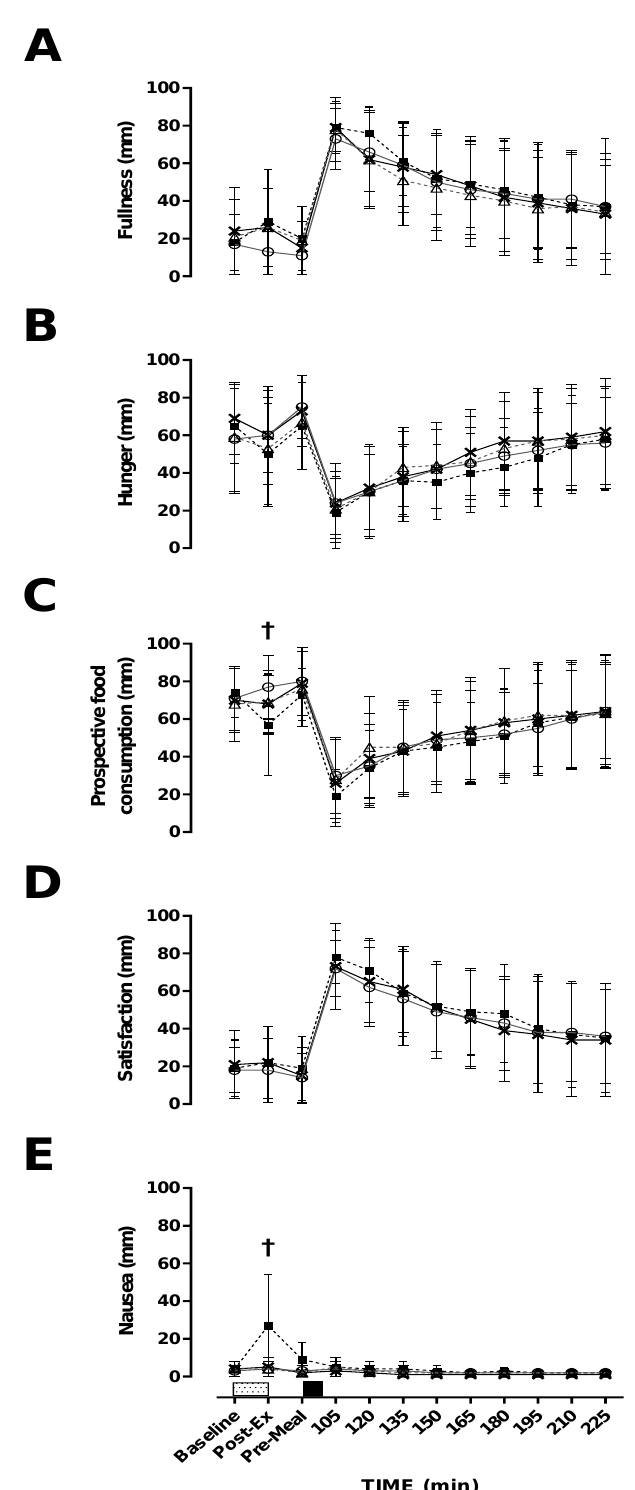
Figure 1. Visual analogue scale (VAS). ( A ) fullness, ( B ) hunger, ( C ) prospective food consumption, ( D ) satisfaction and ( E ) nausea during; LOW-INT ( ▲ ) , LOW-CON ( ○ ), MOD-INT ( ■ ) and MOD-CON (x). Solid lines represent continuous trials and hashed lines represent intermittent trials. Data points are means with vertical error bars representing SDs ( n = 12). Unfilled rectangles with black spots indicate 60-min exercise period; filled rectangle indicates a semi-solid meal. † Indicates MOD-INT trial significantly different from all other trials, determined by Bonferroni adjusted paired t -test ( p < 0.05).